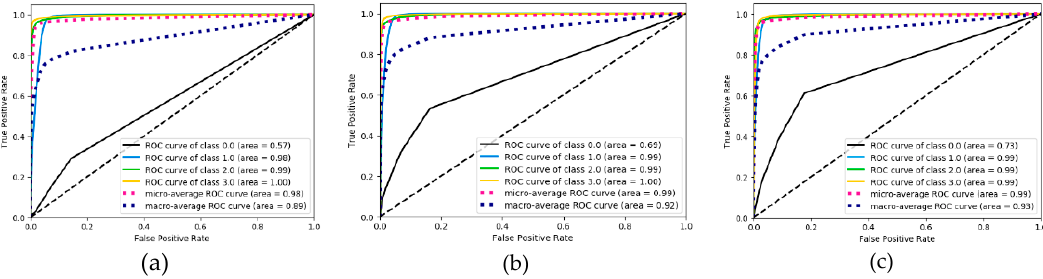
Figure 10. ROC curve performance derived from LSTM classification under three pace settings: 0.78 m/s ( a ), 1.0 m/s ( b ) and 1.25 m/s classes ( c ).